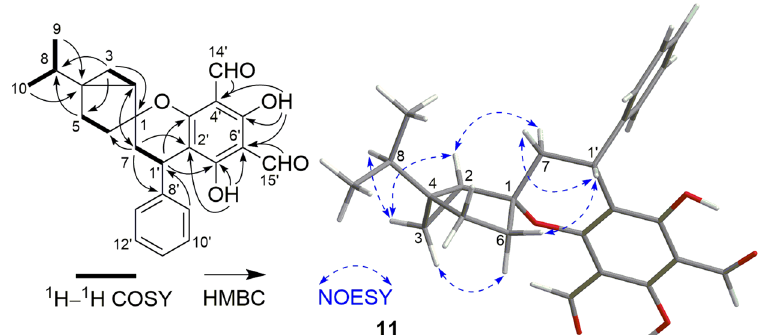
Figure 12. Selected 1 H– 1 H COSY, HMBC, and NOESY correlations of 11